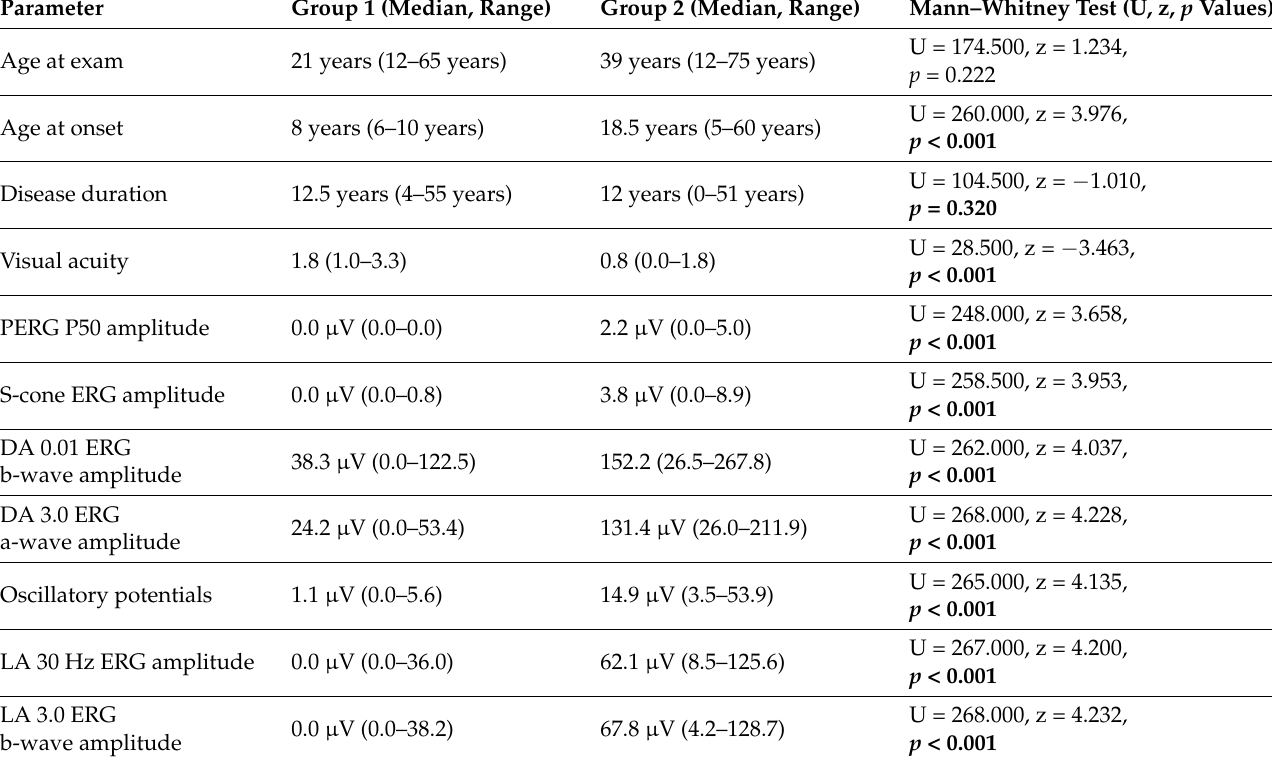
Table 1. Data and results of analyzed clinical characteristics.